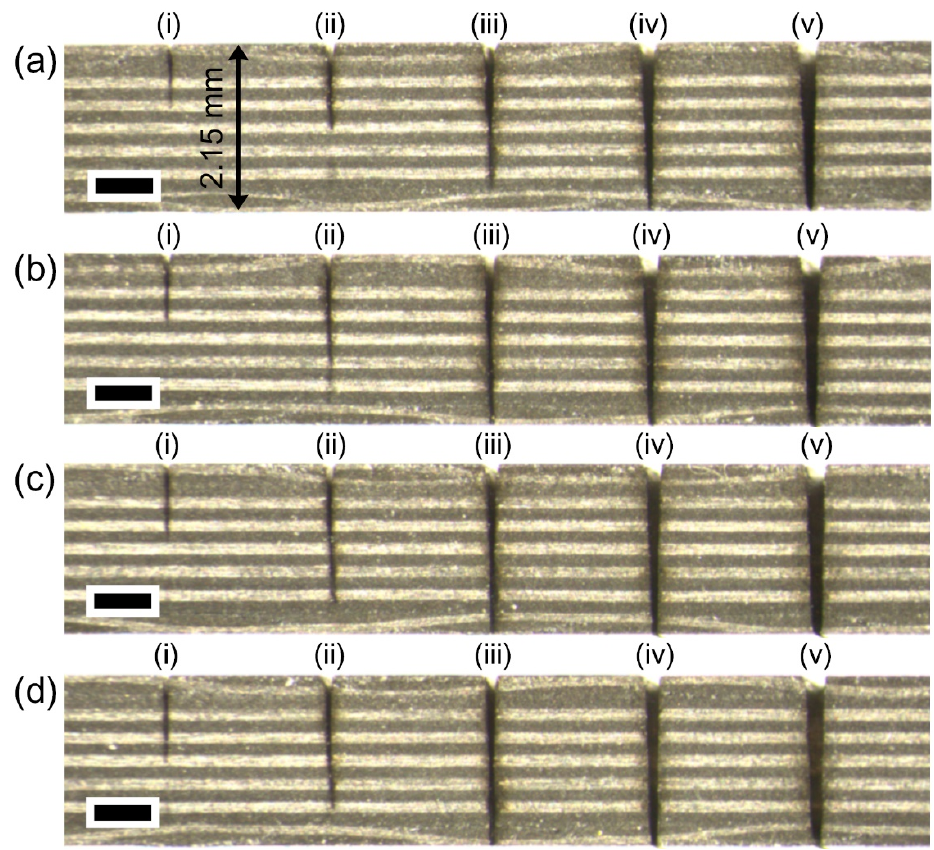
Figure 3. Picosecond laser cutting of thermoset CFRP with lateral multi-pass processing. Stereoscopic microscope cross-section images with ( a ) 50 loops, ( b ) 100 loops, ( c ) 200 loops, and ( d ) 300 loops, respectively. Each position at (i), (ii), (iii), (iv), and (v) corresponds to multi-pass processing of 1, 5, 10, 15, and 20 passes in lateral direction with 10 µm gap. The common experimental conditions were a power of 22 W and a scan speed of 0.5 m/s. Each scale bar = 700 µm.